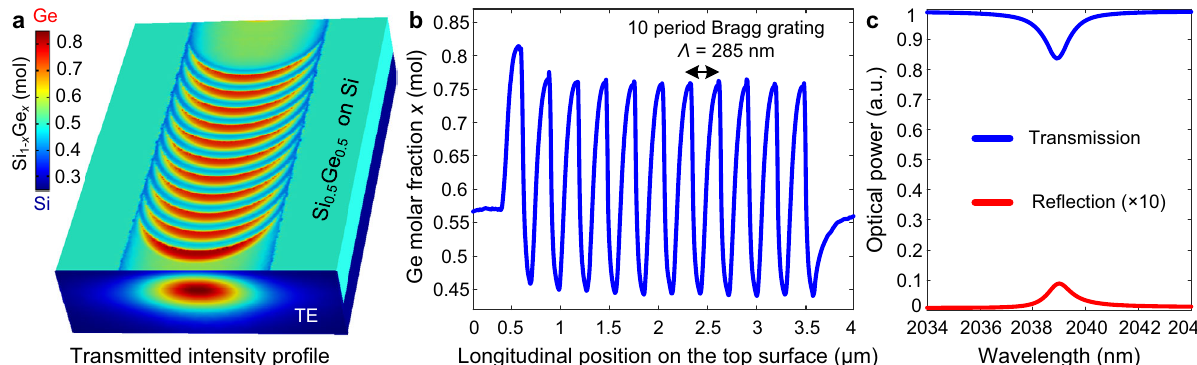
Fig. 7 Laser-written in-plane transverse SiGe superlattice on a silicon substrate as a waveguide Bragg grating. a Composition color map shows the periodic Ge molar fraction x on the top surface of an in-plane transverse SiGe superlattice written at a constant stage scan speed of 25 mm s − 1 , using a sawtooth wave modulation of the laser beam position (back and forth movement of 200 nm) in the scan direction. Calculated optical intensity pro fi le of a transverse electric (TE) polarized mode is shown as superimposed on the output facet of the simulated waveguide Bragg grating. b Ge molar fraction pro fi le as a function of position along the center line on the top surface showing a 10-period grating with a period of 285 nm. c Calculated transmission and re fl ection spectra of the 10-period SiGe waveguide Bragg grating by using fi nite-element-method (FEM)-based optical simulations. The re fl ection data (red bottom line) is magni fi ed ten times